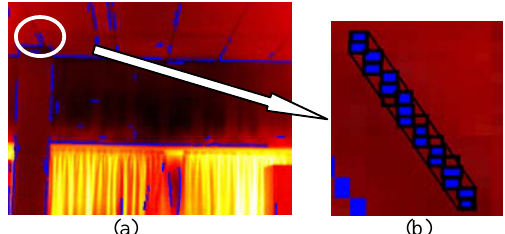
Figure 3. (a) Thermography in which lines have been detected with the LSD by (Grompone et al., 2010); (b) detail of a line- rectangle of width 2 formed by a group of pixels.